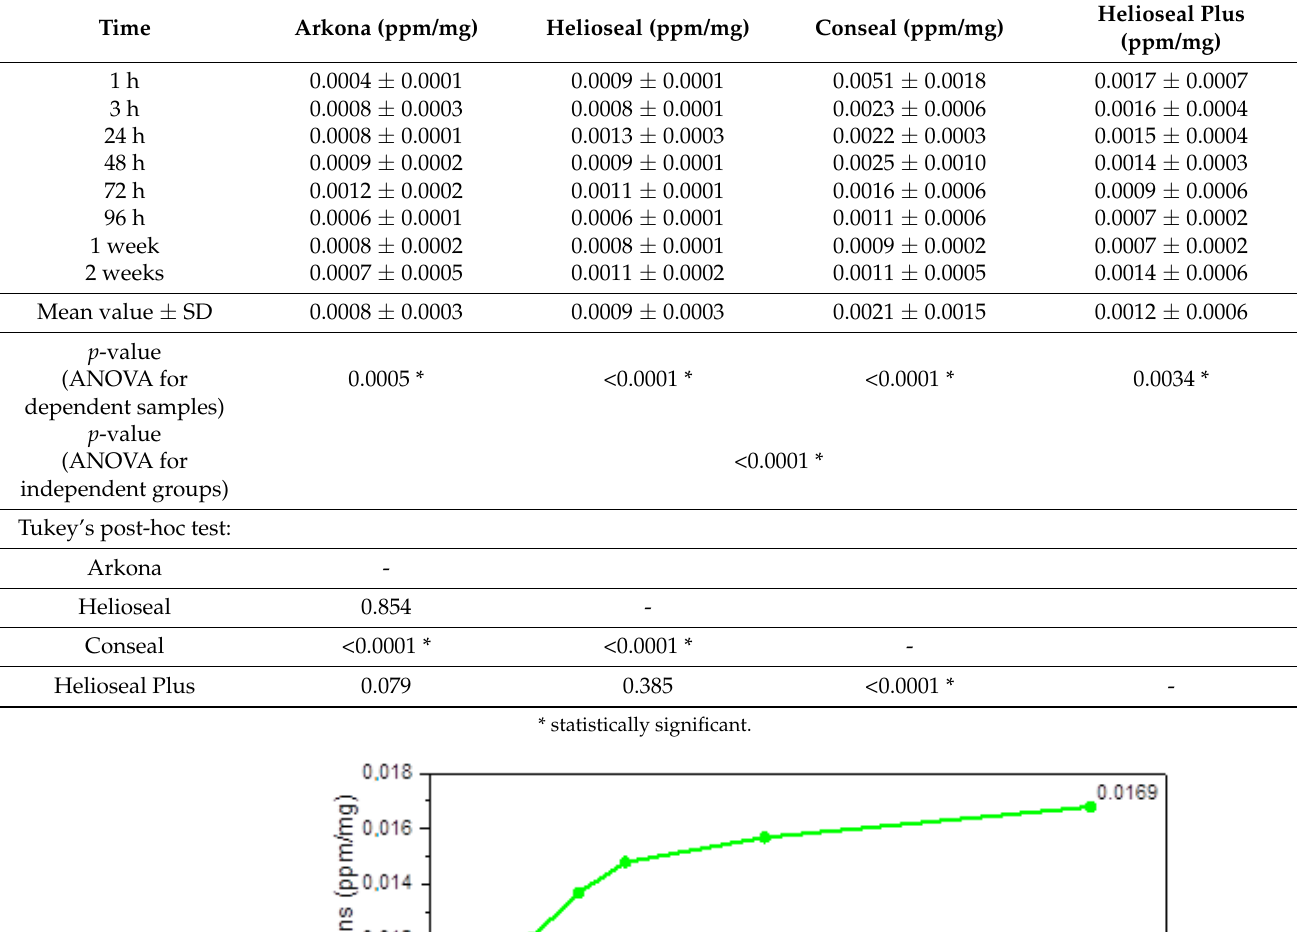
Table 1. Fluoride ion release (ppm/mg) from fissure sealants into a saline solution (0.9% NaCl). Descriptive data are presented as mean values + standard deviation (SD).